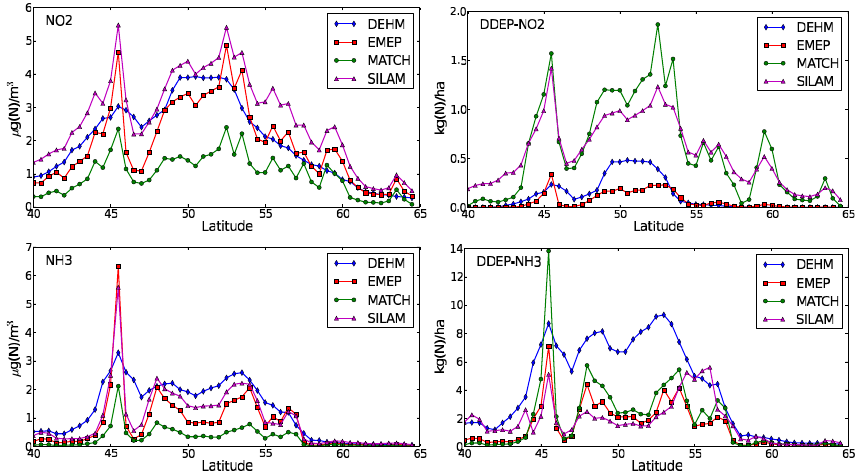
Figure 4. Examples of model variability for two compounds. Calculated base-case concentrations (left column, µg ( N ) m − 3 ) and dry depo- sitions (right column, kg ( N ) ha − 1 ) along the 10 ◦ E transect (cf. Fig. 1) for NO 2 (top row) and NH 3 (bottom